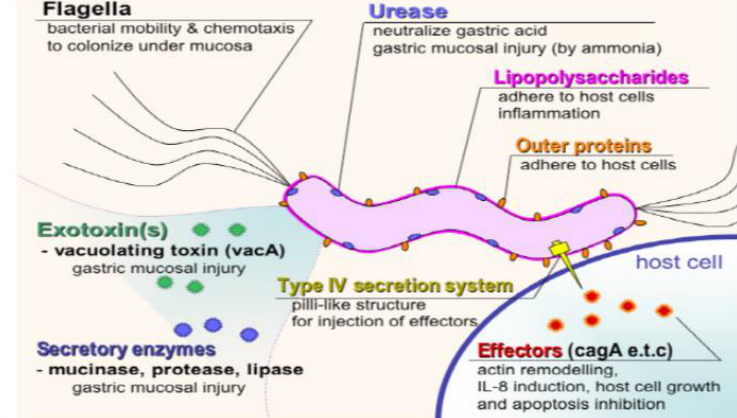
Fig. 2. Component of H. pylori with biological activities (Henriksson et al.,